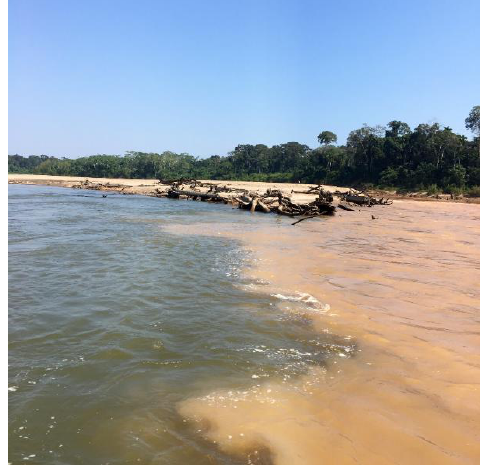
Figure 2. Photo looking upstream at the confluence of the relatively clear Tambopata River (left) and the more turbid Malinowski River (right), during the dry season sampling event in August